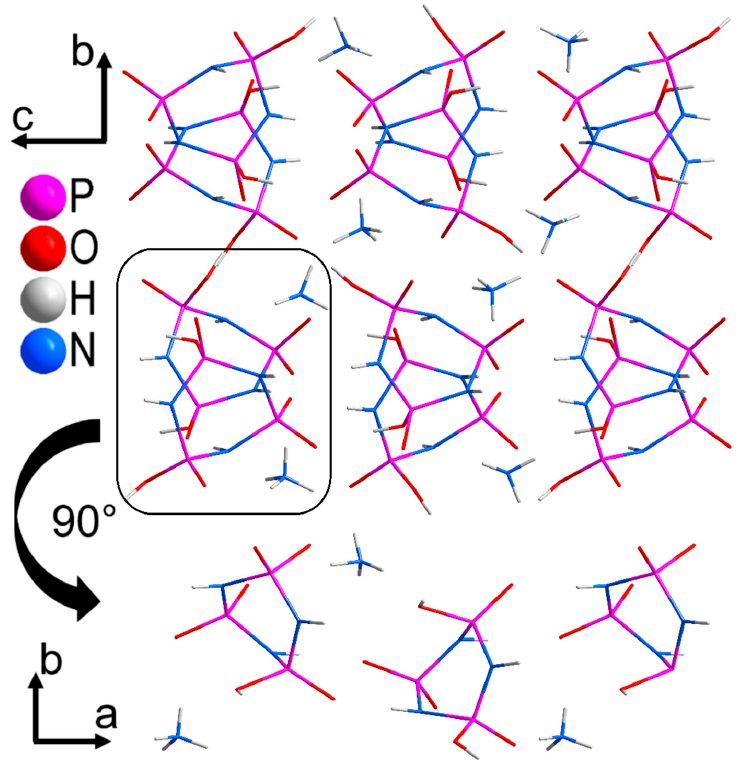
Figure 2. Crystal structure of (NH 4 )H 2 (PO 2 NH) 3 with crankshaft-like stacks of the [H 2 (PO 2 NH) 3 ] − anions.